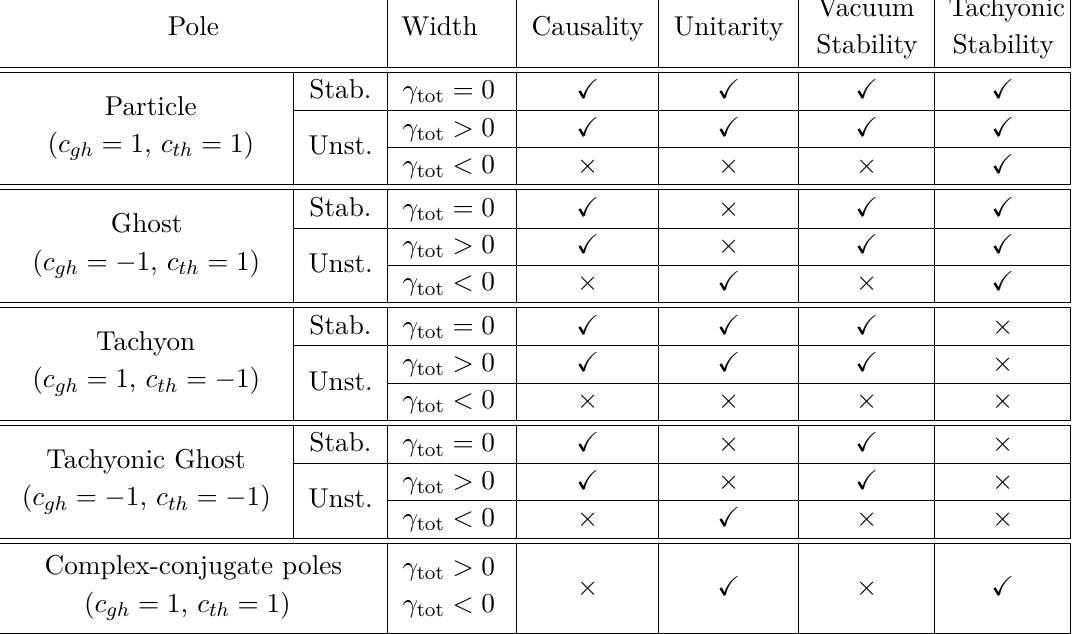
Table 2 . Summary of poles of the dressed propagator satisfying ( X ) or violating ( × ) the conditions of causality (no backward propagation of modes with positive energies), unitarity (no negative-norm states), vacuum stability (no modes with negative energy coupled with modes with positive energies), and tachyonic stability (no runaways in the free-field